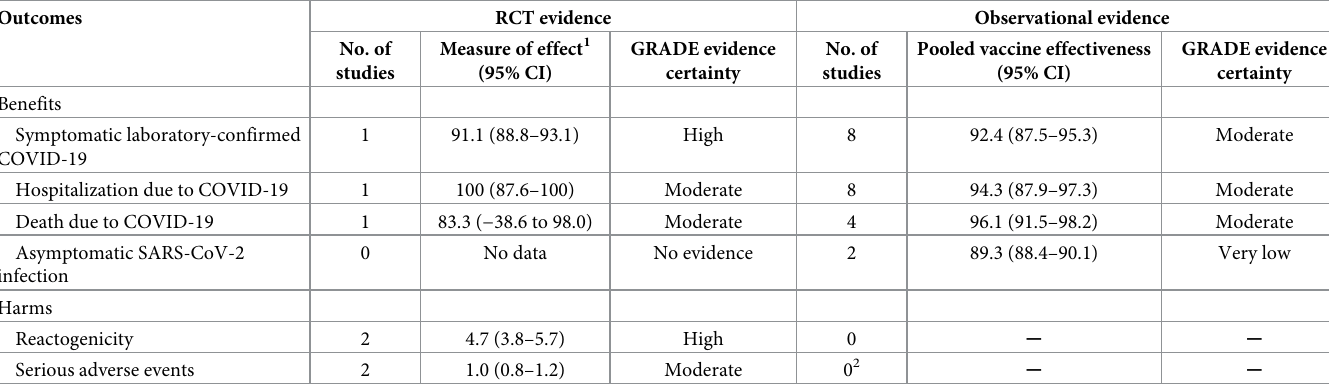
Table 1. Summary results from grading of recommendations, assessment, development and evaluation for Pfizer-BioNTech COVID-19